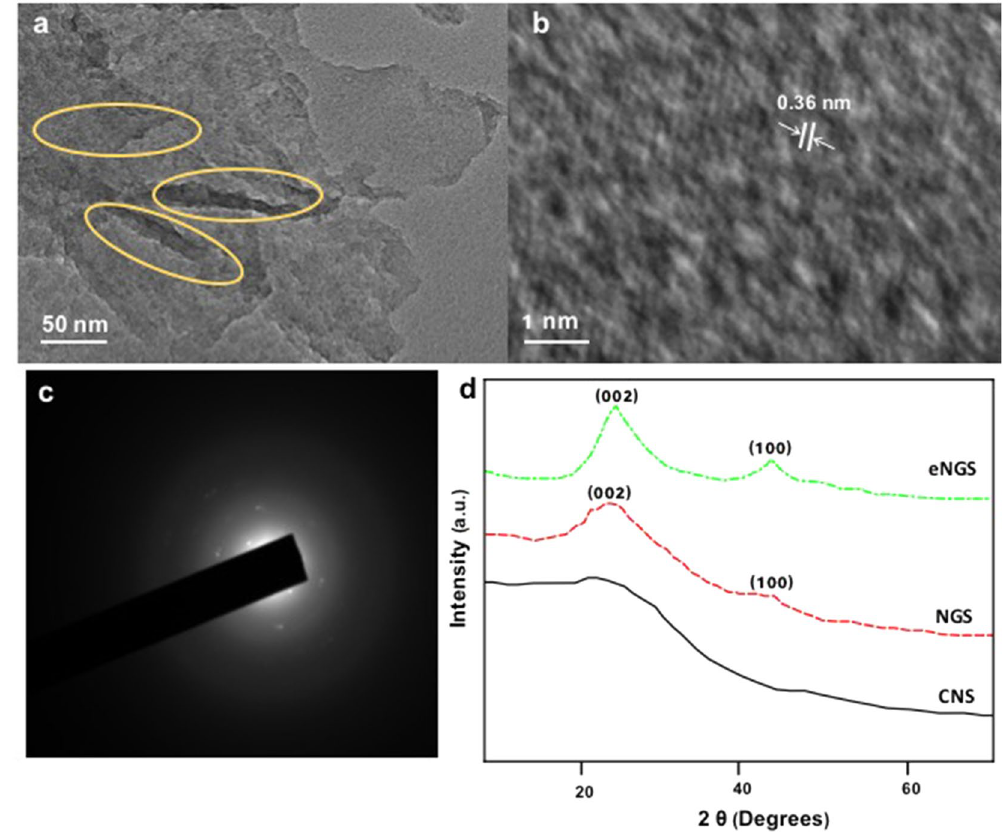
Figure 2. ( a ) Surface topographies of eNGS by HRTEM (yellow circles highlight the wrinkled and folded areas in the sheets) ( b , c ) SAED patterns of eNGS and ( d ) X-ray diffraction patterns of eNGS, NGS, and